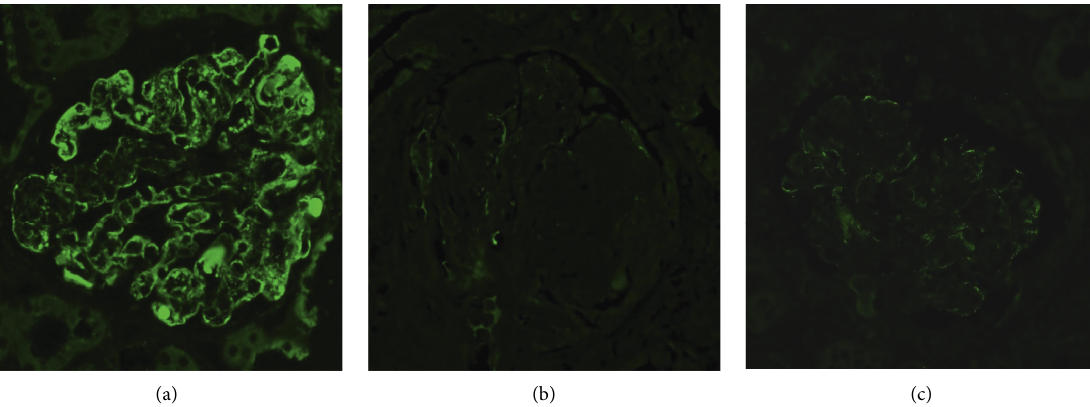
Figure 5: Immunofluorescence staining of KM55 shows global, granular, mesangial, and capillary wall as well as intracapillary pseu- dothrombi staining on initial kidney biopsy (a) and diminished/minimal glomerular capillary wall staining on sequential kidney biopsies three weeks (b) and five months (c) after surgical resection of clear cell renal cell carcinoma. Original magnification: 400X in